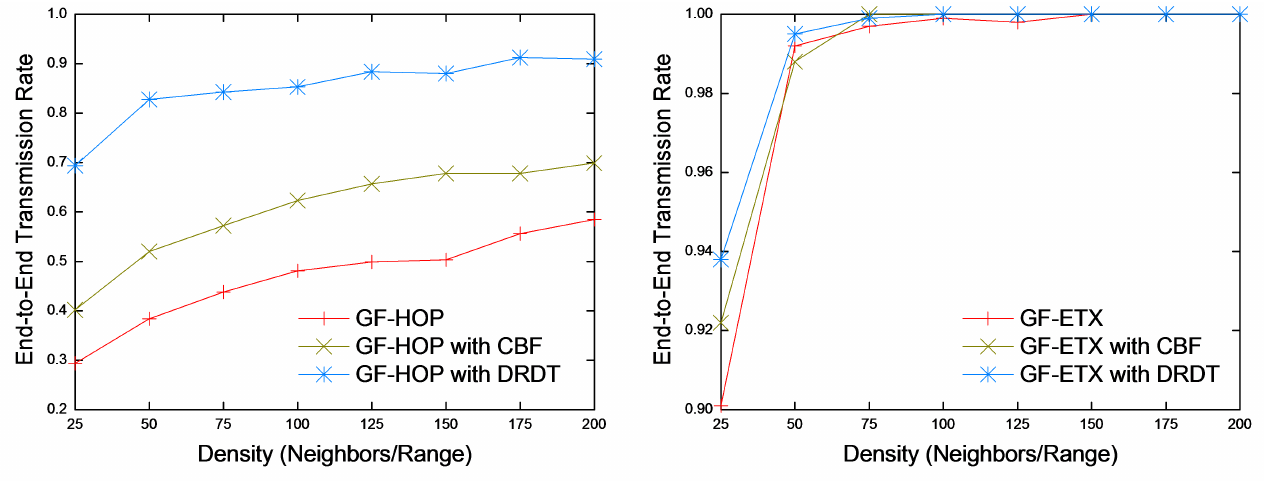
Figure 9. End-to-end transmission